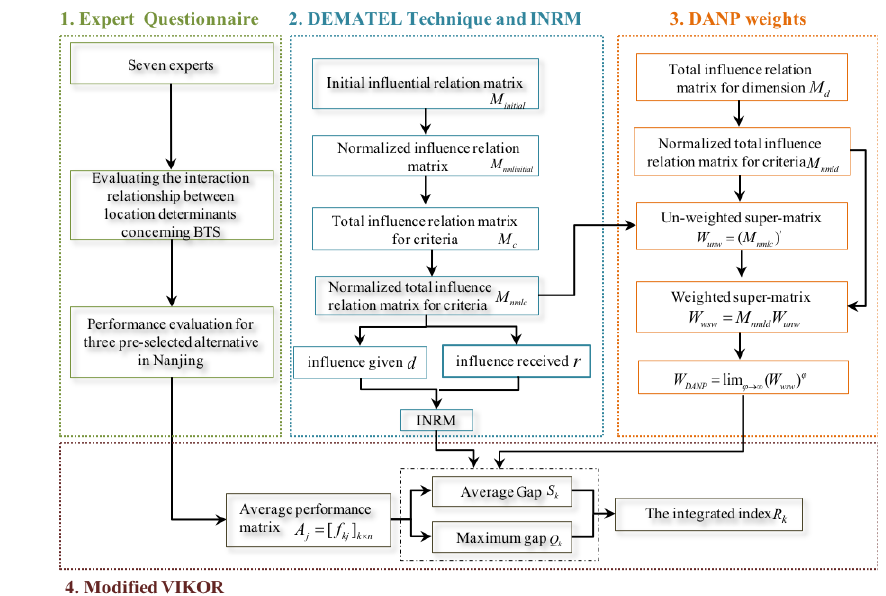
Figure 3. MADM procedures for exploring the location determinants of